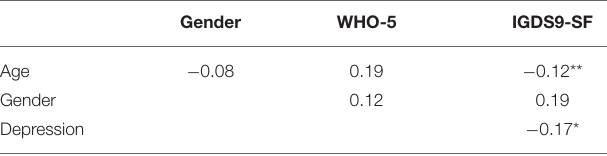
TABLE 2 | Pearson’s correlation co-efficients for the study’s main variables.